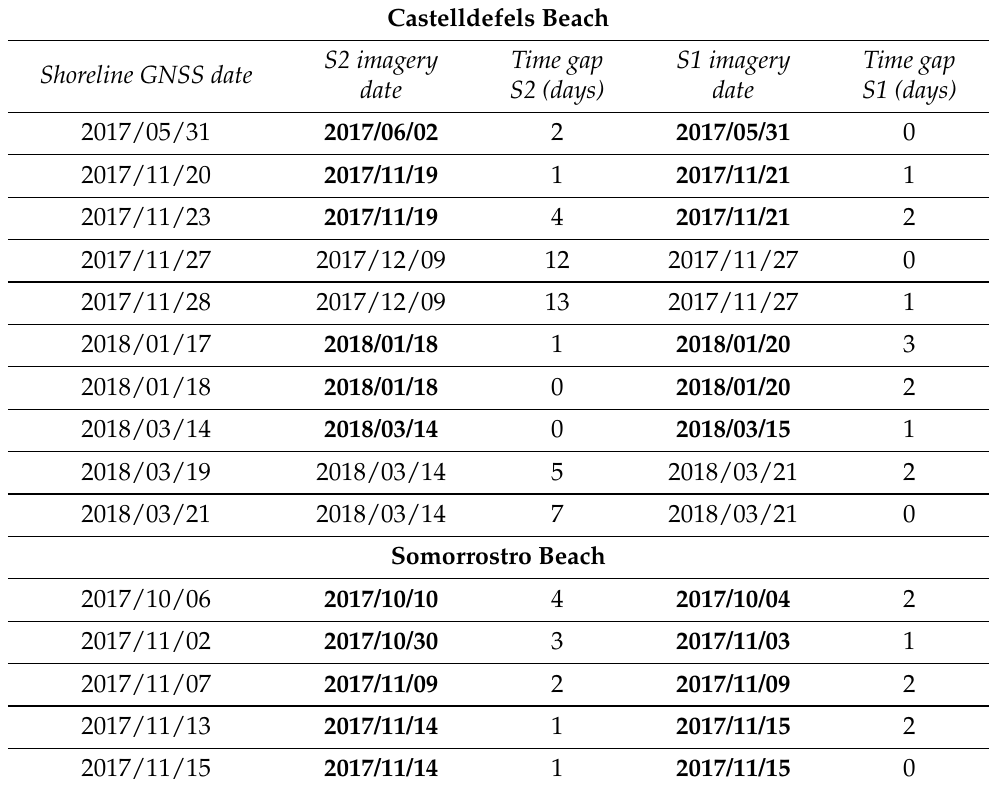
Table 1. GNSS (Global Navigation Satellite System) data acquisition dates, Sentinel-2 (S2) and Sentinel-1 (S2) imagery dates and relative time